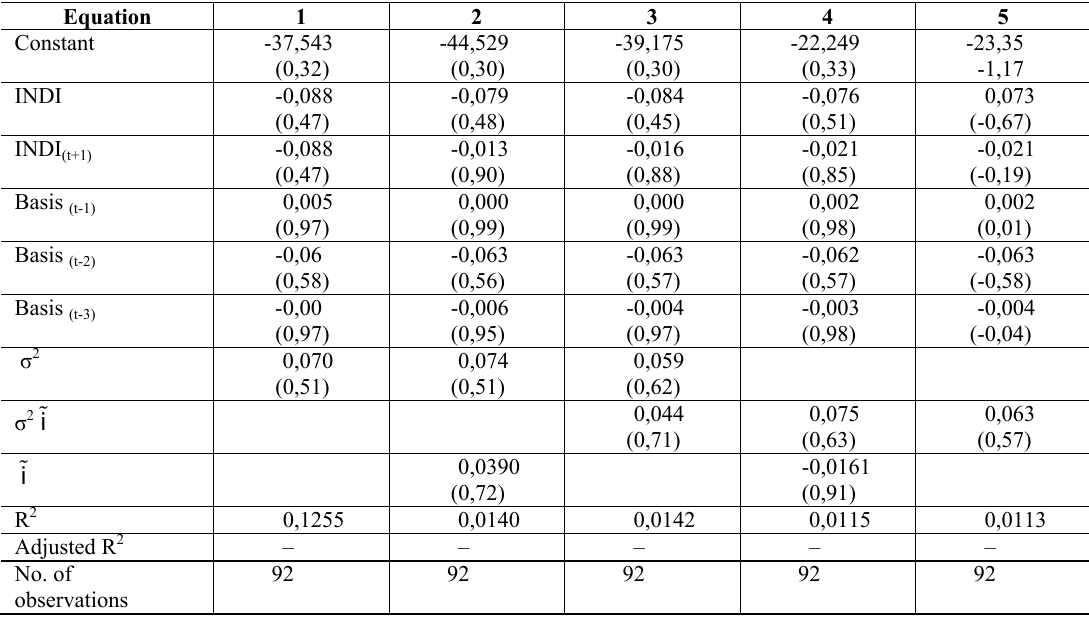
Table 6: Daily regressions of implied volatility on basis - INDI Equation